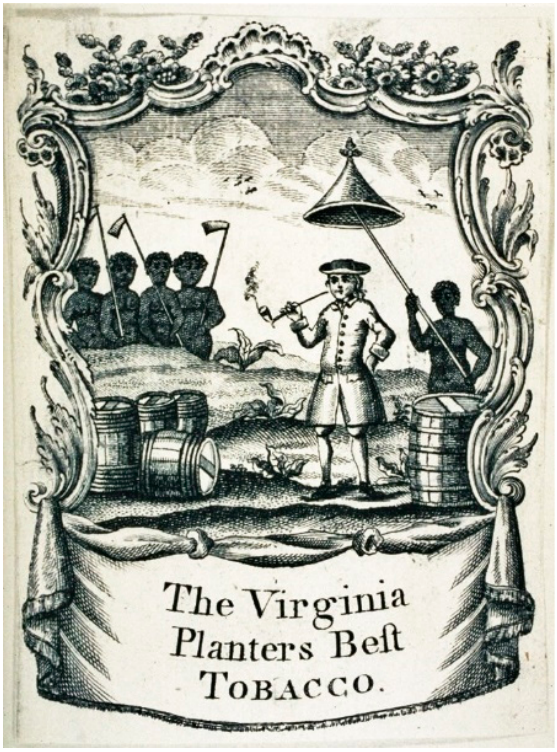
Figure 2. A tobacco label, The Virginia Planters Best Tobacco, 18th century (NW0046). Colonial Wil- liamsburg Foundation. Public domain.